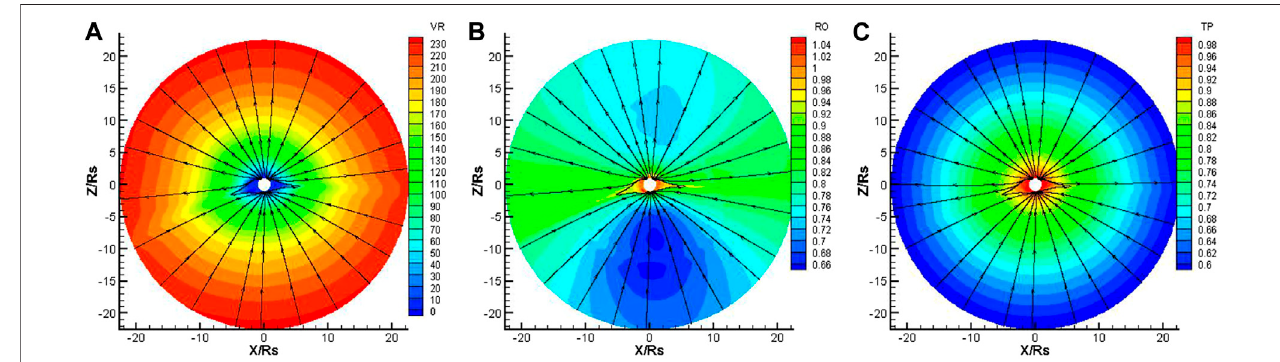
FIGURE 1| The distribution of the radial speed VR (km/s) (A) , density RO × 10 8 (/cm 3 ) (B) and temperature TP × 10 6 (K) (C) on themeridional plane of Φ (cid:2) 180 ° – 0 ° from 1 to 22.5R s , deduced from model A. The streamline represents the magnetic fi eld